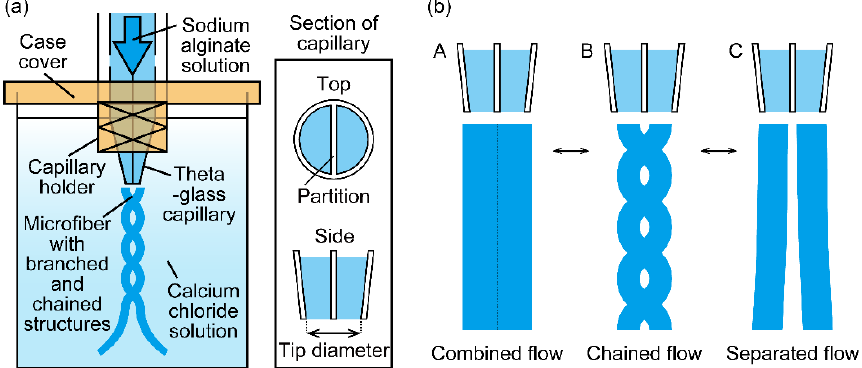
Figure 1. Schematic of the formation of alginate microfibers: ( a ) formation of alginate microfibers with branched structures using a theta-glass capillary; ( b ) conceptual illustrations of three flow regimes of two streams extruded from the theta-glass capillary (A: combined flow, B: chained flow, C: separated flow).